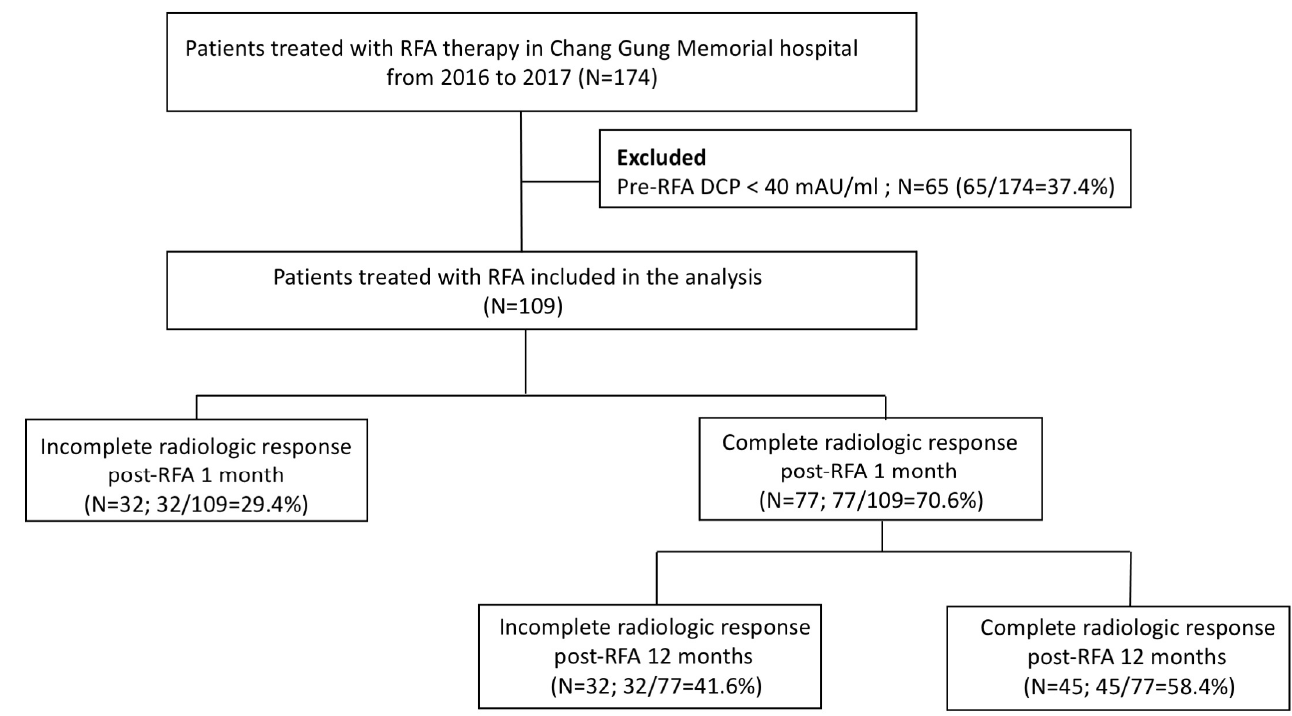
Figure 1. Flow diagram of enrolled patients with tumor marker Des-gamma-carboxy prothrombin (DCP) and radiofrequency ablation (RFA) therapies in this study. Although absolute levels of AFP and DCP at Pre-RFA and at 1 day post RFA